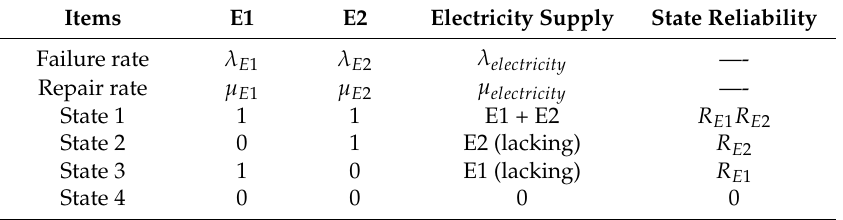
Table 6. The operation states and reliability data for the electricity subsystem of the CCHP system.